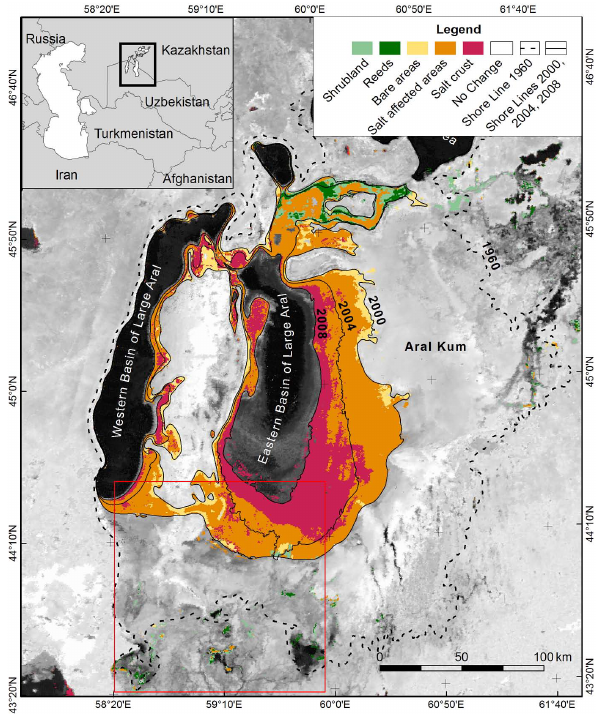
Fig. 3. Location of the study area in the southern Aral Sea Basin. The map shows the major land cover transformations that took place where the sea surface has desiccated between 2000 and 2008. The image backdrop is a Terra MODIS scene acquired on 20 July 2009. Red square indicates the study